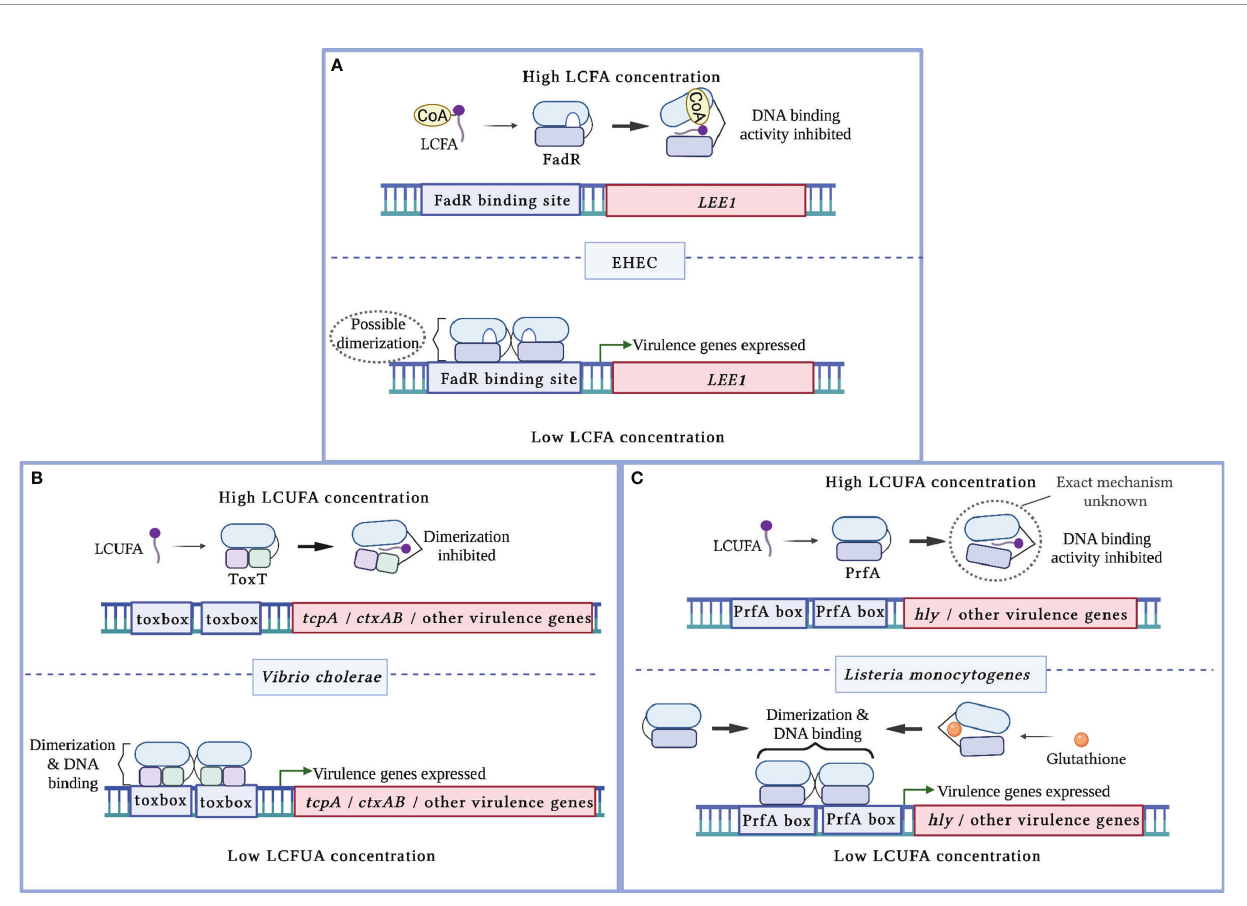
FIGURE 1 | Mechanisms of virulence regulation by LCFA cytoplasmic sensors. (A) In enterohemorrhagic E. coli (EHEC), apo-FadR binds its target DNA sequences at the LEE1 promoter region and functions as a transcriptional activator of ler , which encodes the master activator of the LEE pathogenicity island. In the presence of LCFA-CoAs, FadR binds the CoA moiety of LCFA-CoA. This alleviates FadR binding of DNA, resulting in decreased activation of ler. (B) In V. cholerae , LCUFAs bind the master virulence activator ToxT. This interaction induces a conformational change that precludes ToxT dimerization and DNA binding. As a result, ToxT-mediated activation of tcpA, ctxAB , and other virulence genes is decreased. (C) In L. monocytogenes , LCUFAs bind the master virulence activator PrfA. This interaction inhibits DNA binding by apo-PrfA through a mechanism that has not been fully characterized. As a result, PrfA-regulated virulence genes are not activated. Glutathione allosterically enhances PrfA binding to DNA, resulting in increased expression of PrfA-regulated virulence